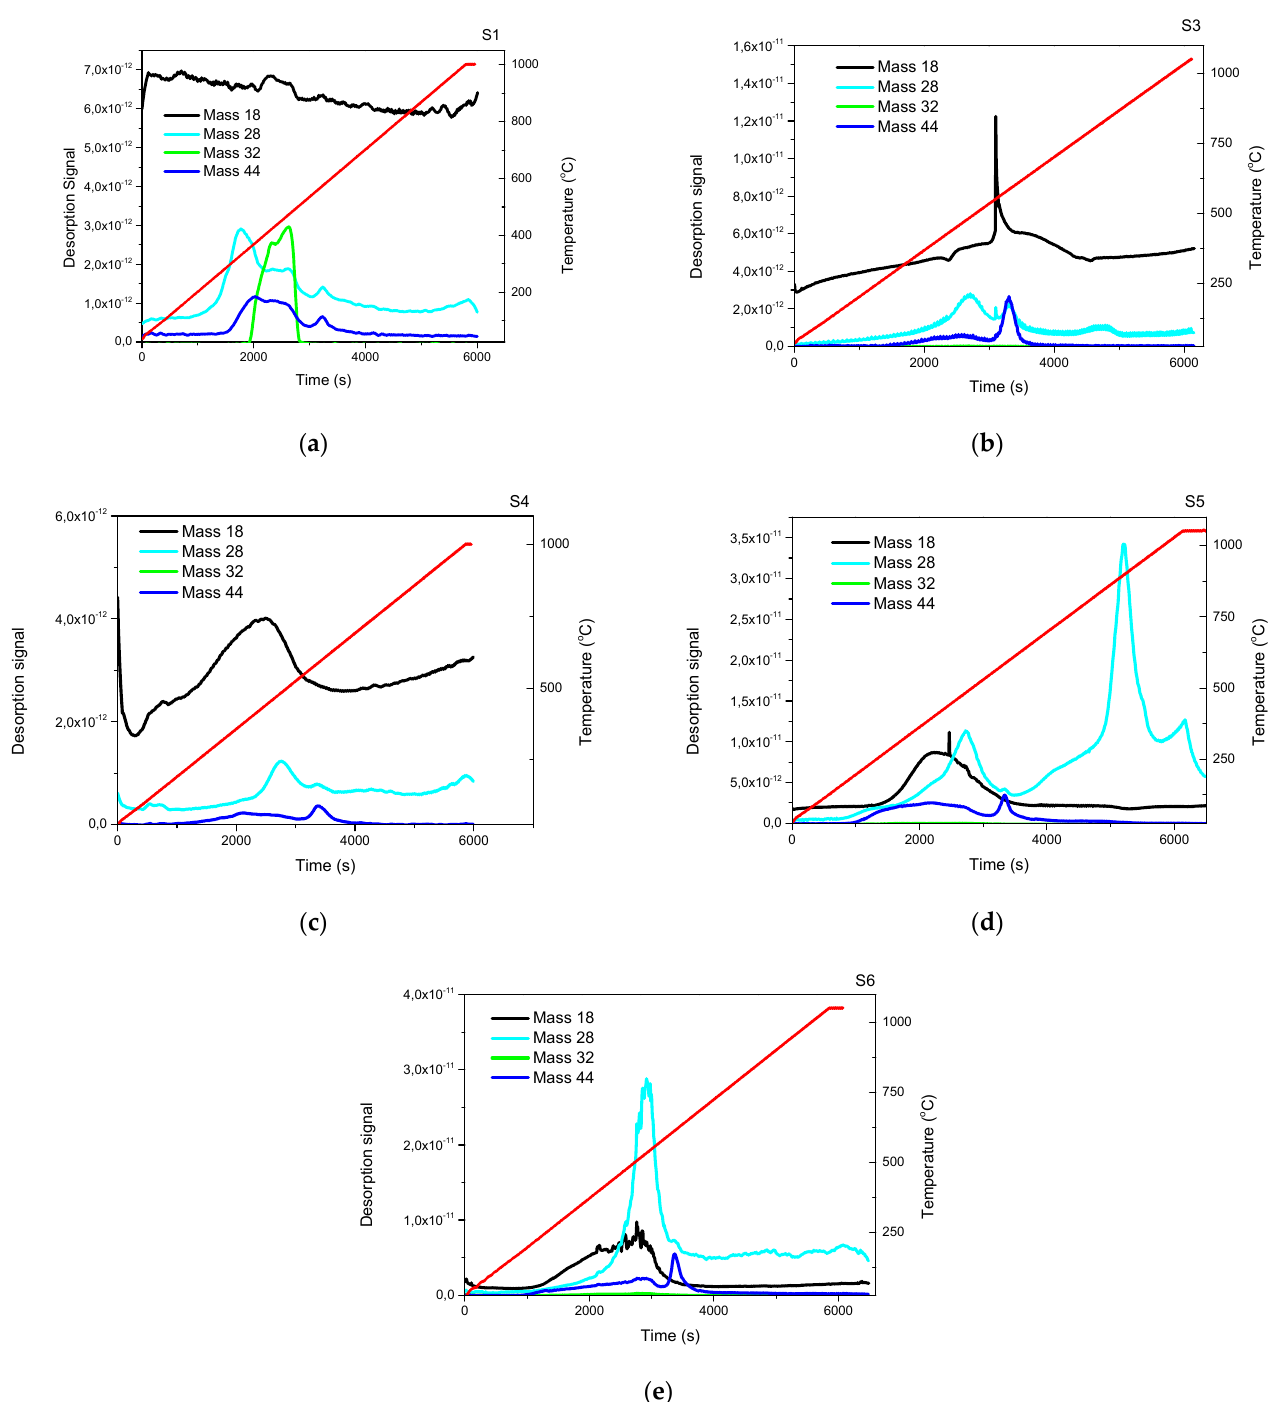
Figure 8. TDS was conducted at a heating rate of 10 °C/min, and spectra were acquired for the following samples: S1 ( a ), S3 ( b ), S4 ( c ), S5 ( d ), and S6 ( e ); S2 was negatively affected by the heating process (severe delamination).